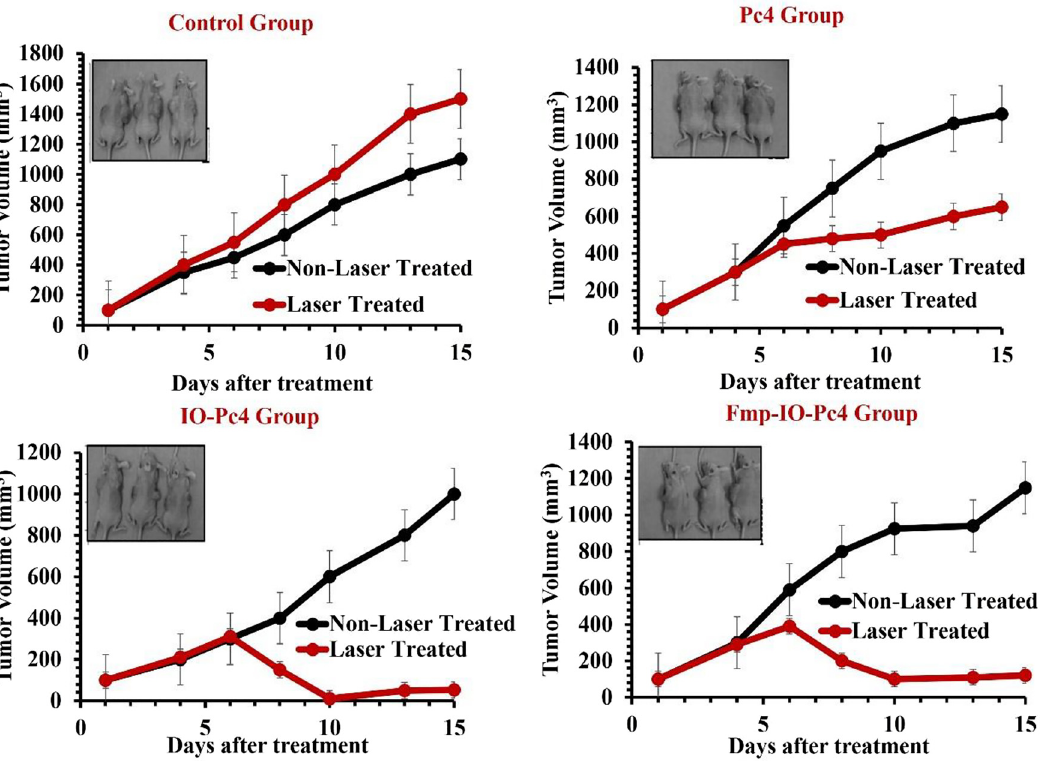
Figure 25: Inhibition of xenograft tumor formation by Pc4 PDT treatment delivered by IO NPs. (A – D) Tumor growth and representative images of tumors on both sides of the mice in (A) PBS control, (B) free Pc4, (C) IO-Pc4, and (D) Fmp-IO-Pc4 groups, respectively with 0.4 mg/kg Pc4. Lasertreatmentwasperformedat48hpostadministration(672nm,100mW/cm 2 for30min).Threeoutofsixmicefromeachgroupareshown as